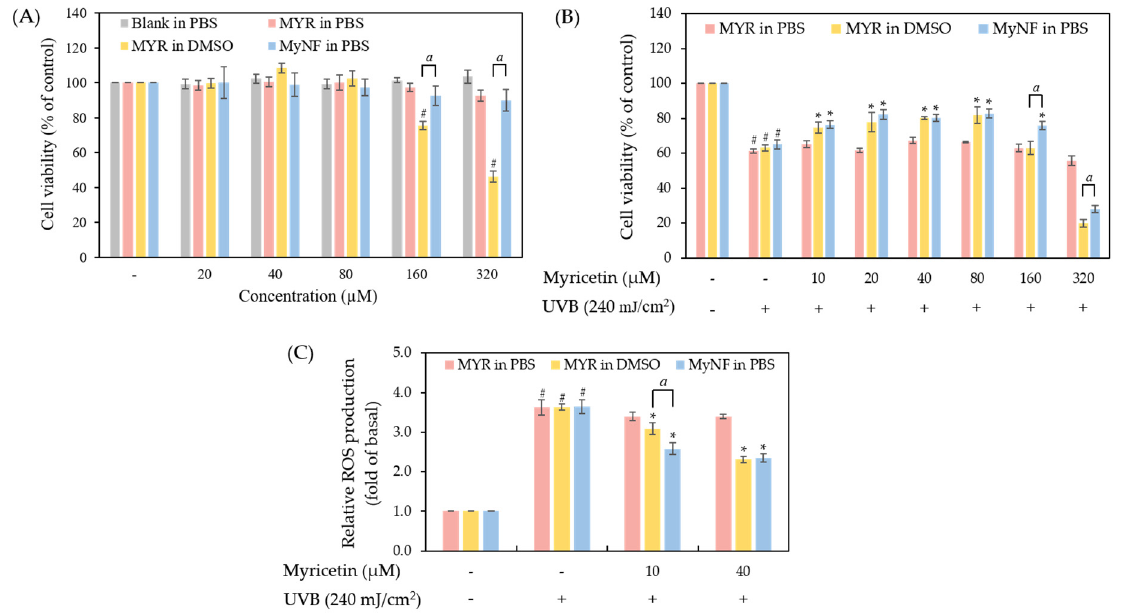
Figure 9. The cell viability and photoprotective effect of MYR and MyNF (1:20:12) in HaCaT keratinocytes. ( A ) The cell viability of HaCaT keratinocytes in pretreatment with MYR in PBS, MYR in DMSO, MyNF in PBS, and NF in PBS. ( B ) The photoprotective effect of MYR and MyNF against UVB-induced damage in HaCaT keratinocytes. ( C ) The ROS production in HaCaT cells in pretreatment with MYR and MyNF after UVB irradiation. All experiments were performed in triplicate and expressed as the mean ± SD ( n = 3). “-” indicates the control group without any treatment and “+” indicates the UVB-irradiated group. # p < 0.05 compared with the control group. * p < 0.05 compared with the UVB-irradiated group. a p < 0.05 was regarded as statistically significant between MYR in DMSO and MyNF in PBS.